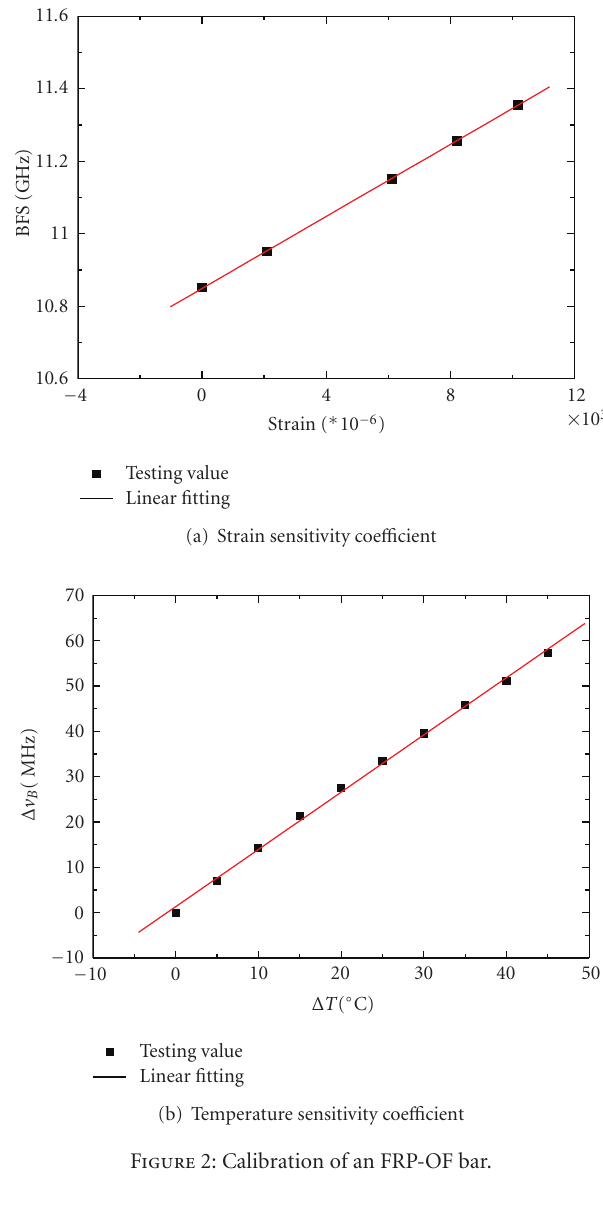
Figure 2: Calibration of an FRP-OF bar.